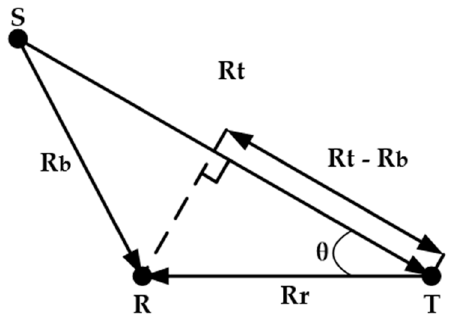
Figure 2. Side view of the bistatic acquisition geometry.